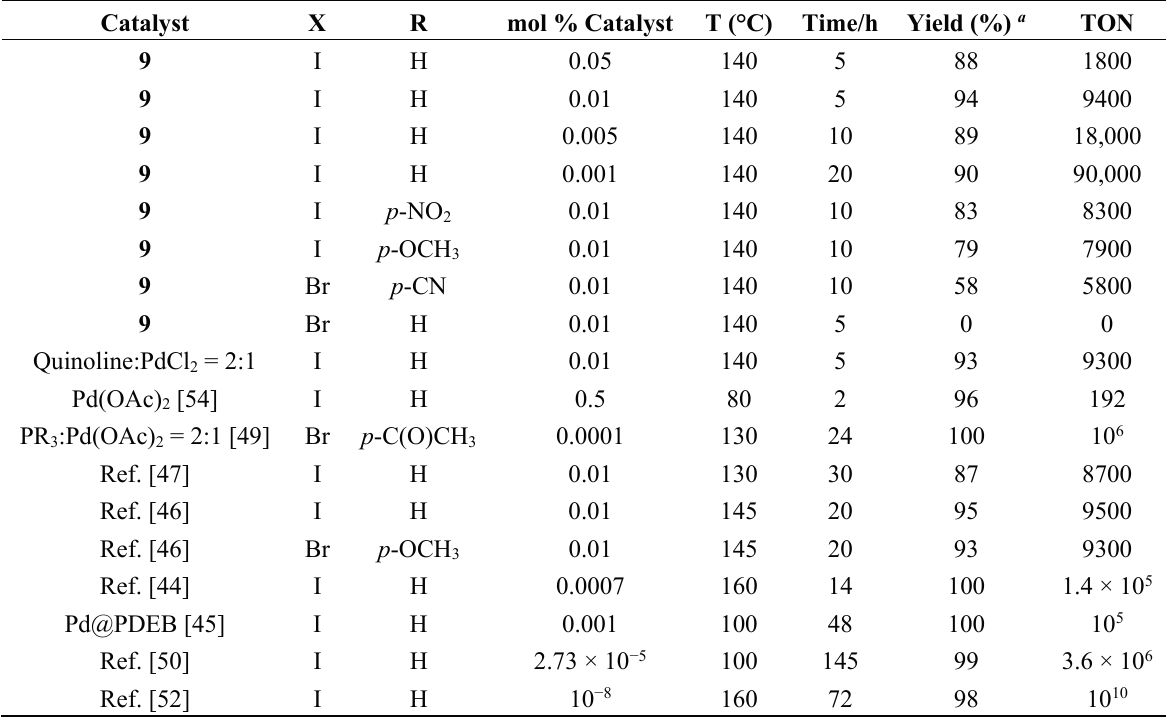
Table 1. Heck coupling reaction of aryl halides with n -butylacrylate using 9 as catalyst and comparison with other data from the literature. a Isolated yield (our